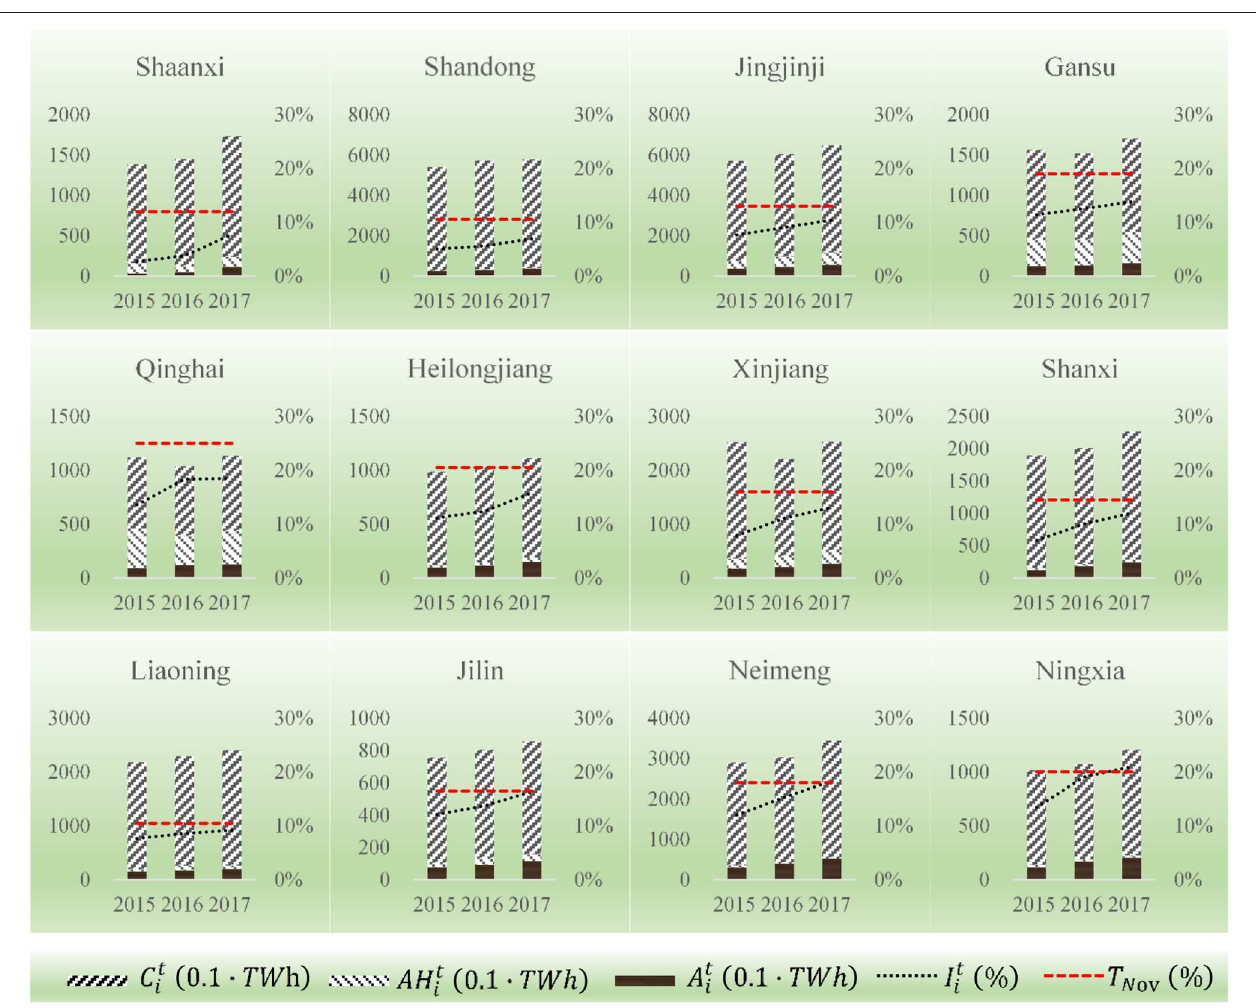
FIGURE 1 | Evolution of the provincial accommodation rate in the “Three North” region,